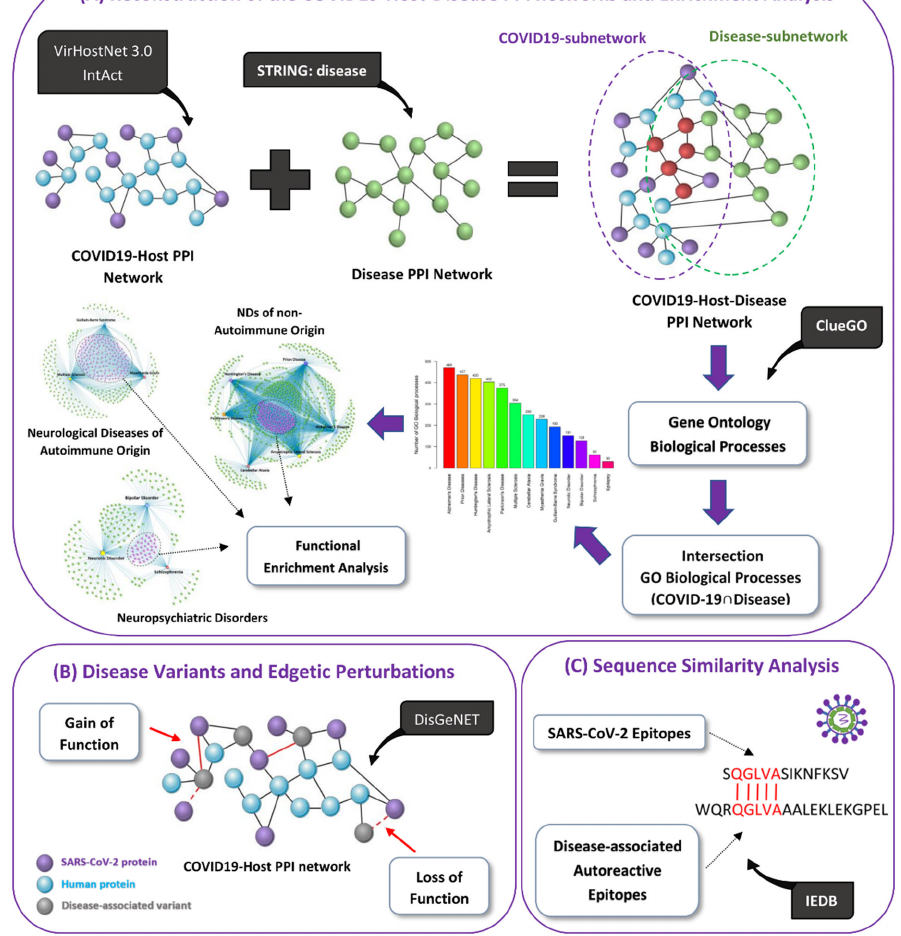
Figure 1. Schematic Representation of the Methodology used in this Study. The aim was to identify potential genetic risk factors and possible pathological mechanisms by which COVID-19 might lead to the development of neurological diseases and neuropsychiatric disorders. ( A ) We represent the various data sources used to reconstruct the COVID-19-Host-Disease PPI networks and the methodology used to identify overlapping Gene Ontology (GO) biological processes (COVID-19 ∩ Disease) between COVID-19 and each of the thirteen included diseases/disorders, by using enrichment analysis. We also identify common COVID-19-mediated pathological mechanisms between COVID-19 and groups of diseases/disorders. ( B ) We also identify possible disease-associated genetic variants that could lead to the emergence of edgetic perturbations in COVID-19-host PPIs. Purple nodes represent SARS-CoV-2 viral proteins, blue nodes human proteins and gray nodes represent human proteins that have genetic variants associated with disease development and are also targeted by SARS-CoV-2 viral proteins. ( C ) Finally, we perform pairwise sequence similarity analysis between SARS-CoV-2 epitopes and autoreactive epitopes found in neurological diseases to identify the presence of 5-mer and above matching linear motifs in their consensus sequence, with the aim to determine the potential risk of autoreactivity of SARS-CoV-2 epitopes with human